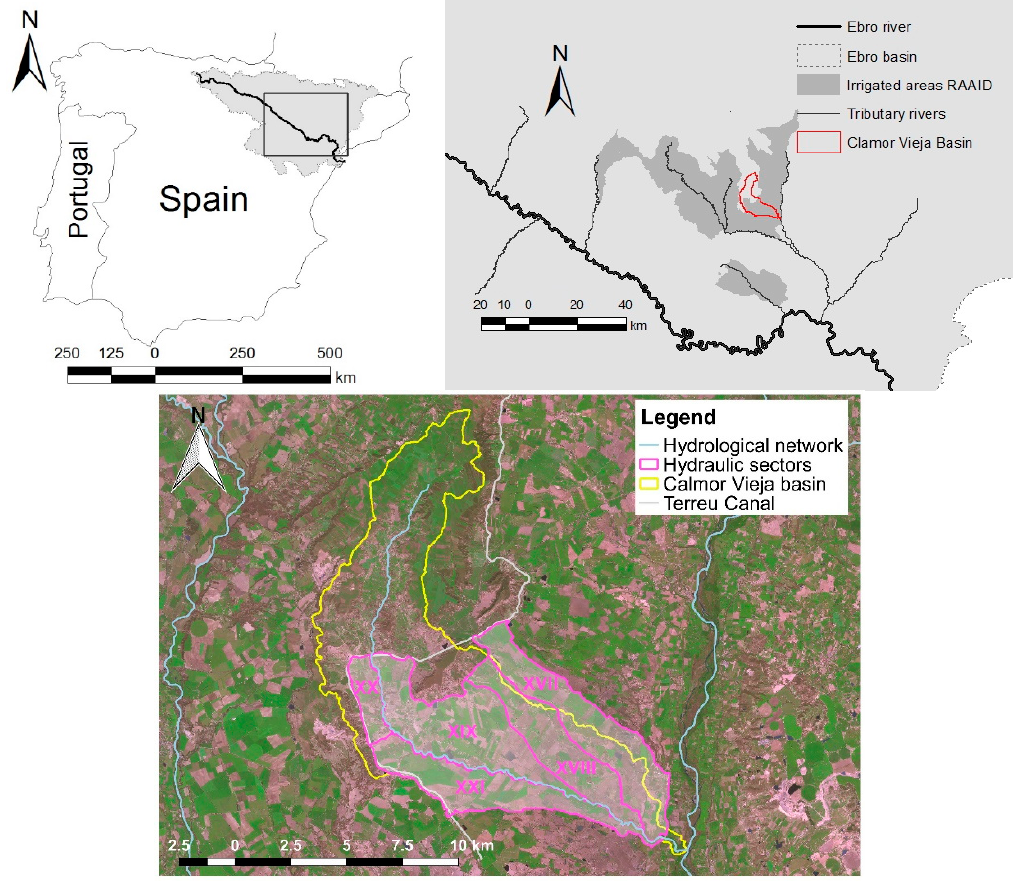
Figure 1. ( Top left ) Ebro River basin location and ( top right ) Clamor Vieja basin location. RAAID stands for Riegos del Alto Aragón Irrigation District. ( Bottom ) Hydraulic sectors in the Clamor Vieja irrigation district.